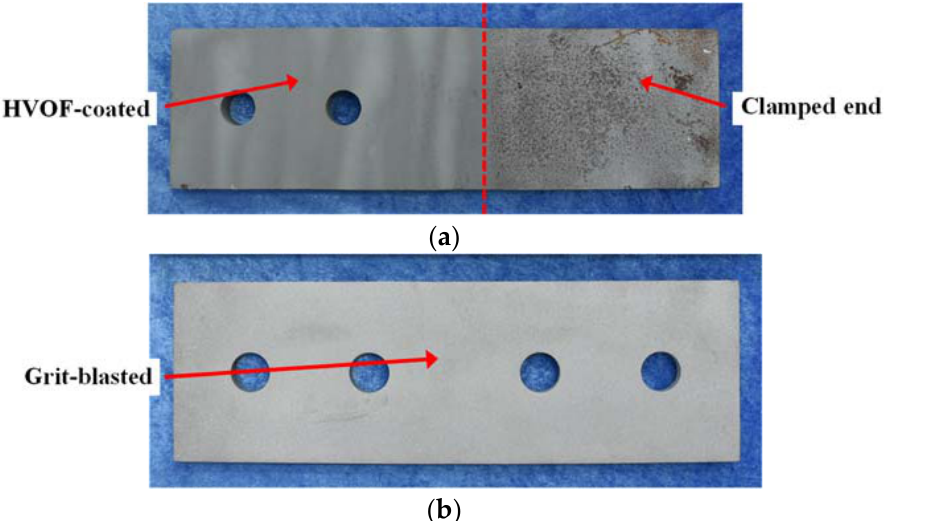
Figure 1. Two sides of the new surface treatment method. ( a ) Inner plate (HVOF-coated). ( b ) Cover plate (grit-blasted).